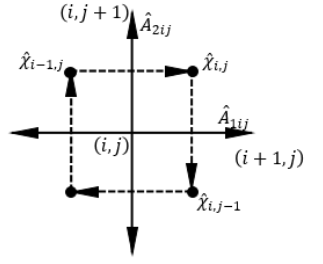
Figure 1 . Dual lattice: the scalar (cid:12)eld operator ^ (cid:31) is in the center of the plaquette, and the gauge (cid:12)eld operator ^ A in some link is equal to a di(cid:11)erence of scalar (cid:12)elds across the link in the dual lattice which is perpendicular to the one corresponding to ^ A . The duality of gauge (cid:12)eld momentum operator (cid:25) is in the same